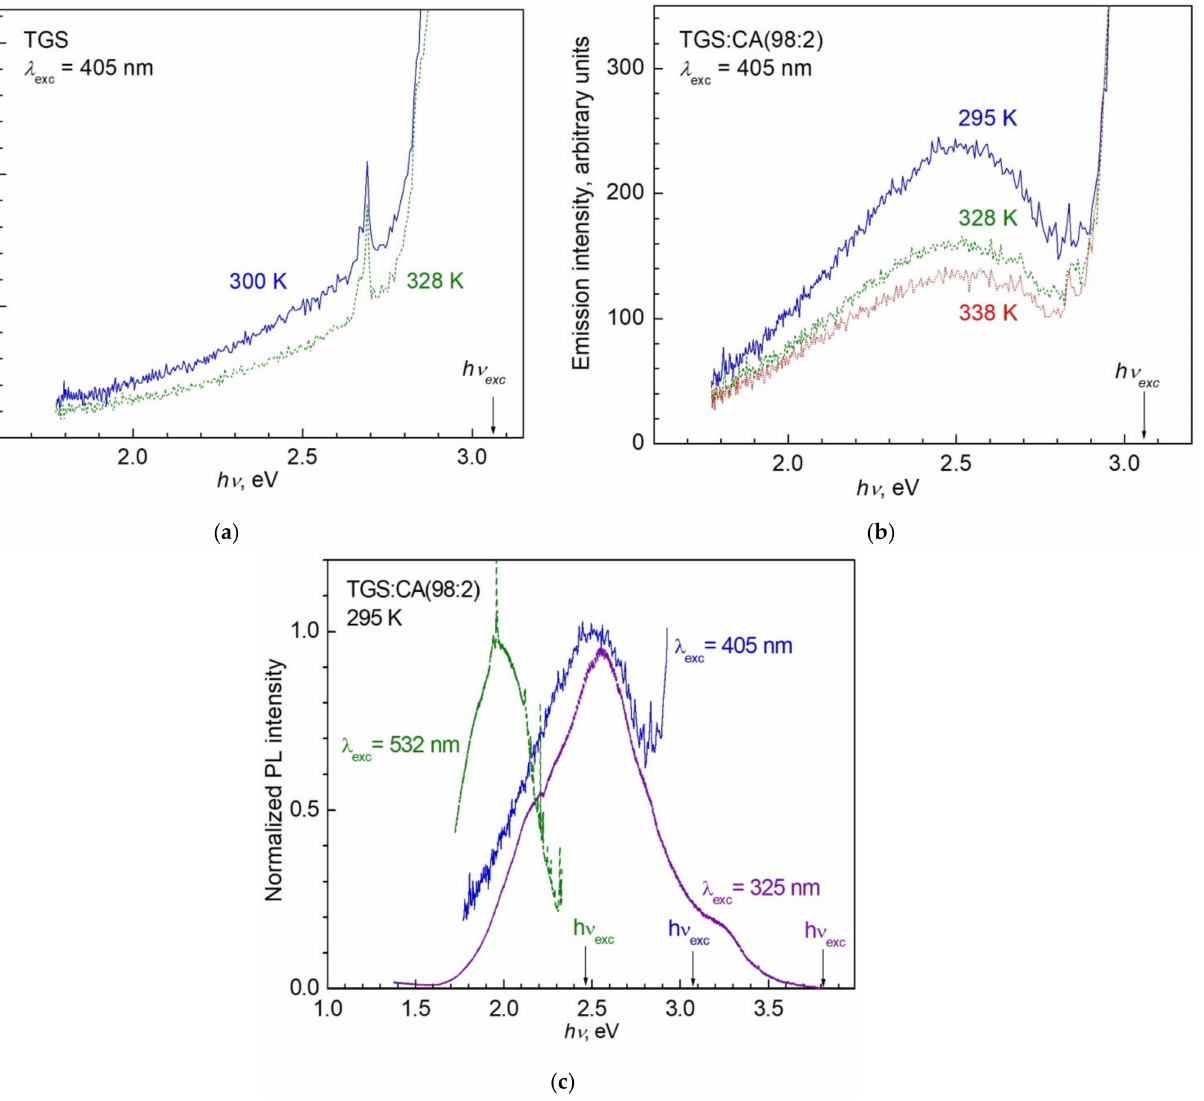
Figure 8. PL spectra of ( a ) TGS and ( b ) TGS:CA (98:2) crystal under 405 nm ( E ph = 3.06 eV) laser excitation at different temperatures (specified in the figure). ( c ) Normalized PL intensity of TGS:CA (98:2) crystal at a temperature of 295 K for excitation at λ exc ≈ 532 nm, 405 nm and 325